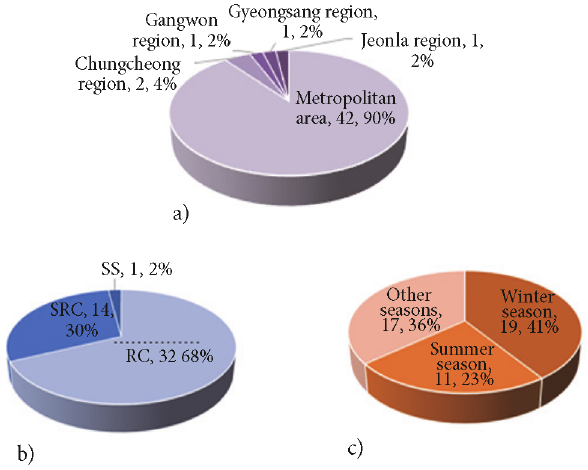
Figure 2. Distribution status of the performance data: